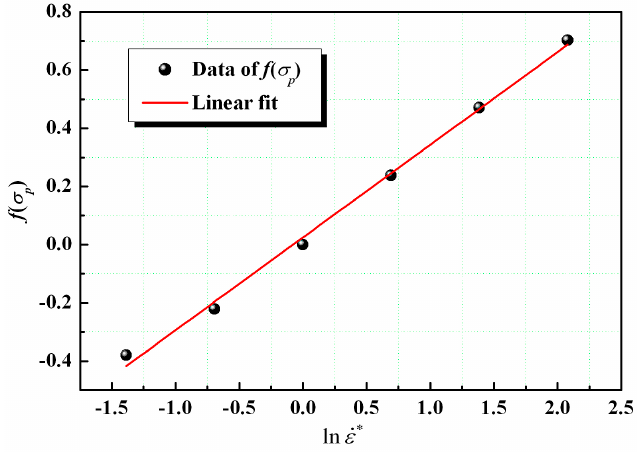
. (cid:0) (cid:1) σ p ε ∗ at T = 970 ◦ C and vs. ln